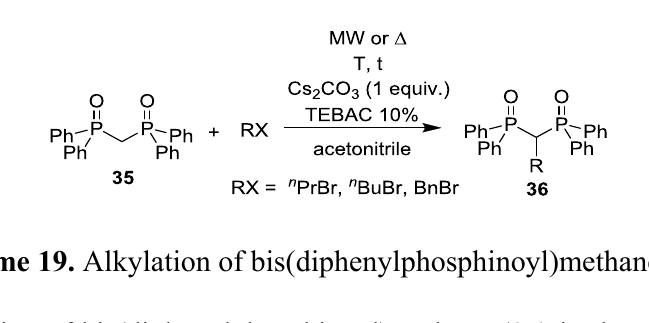
Table 8. Benzylation of bis(diphenylphosphinoyl)methane ( 35 ) in the presence of Cs 2 CO 3 and TEBAC in